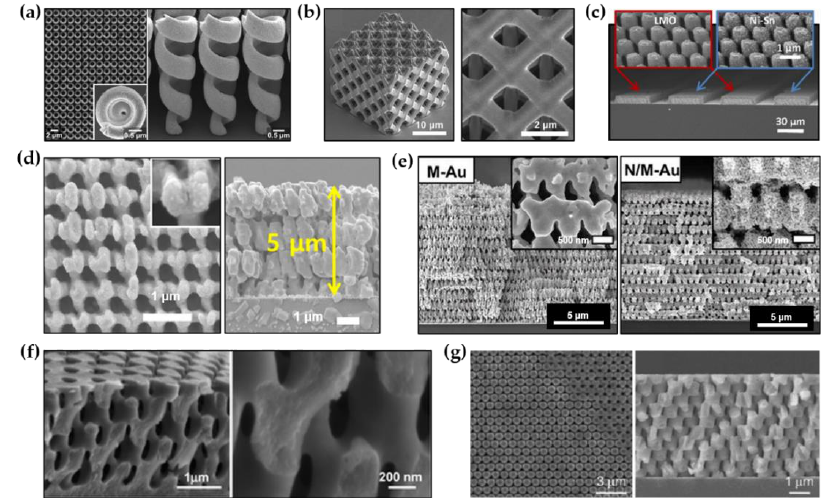
Figure 3. Various inorganic materials with 3D periodic nanostructures formed by template-assisted electroplating. ( a ) SEM images of Au helix structures formed by the combination of DLW and ( b ) SEM images of a Cu meso-lattice formed by the combination of MBIL and electroplating (Reprinted with permission from [81]. Copyright 2015 Elsevier); ( c ) SEM images of mesoporous Ni-Sn electrodes formed by the combination of MBIL and electroplating (Reprinted with permission from